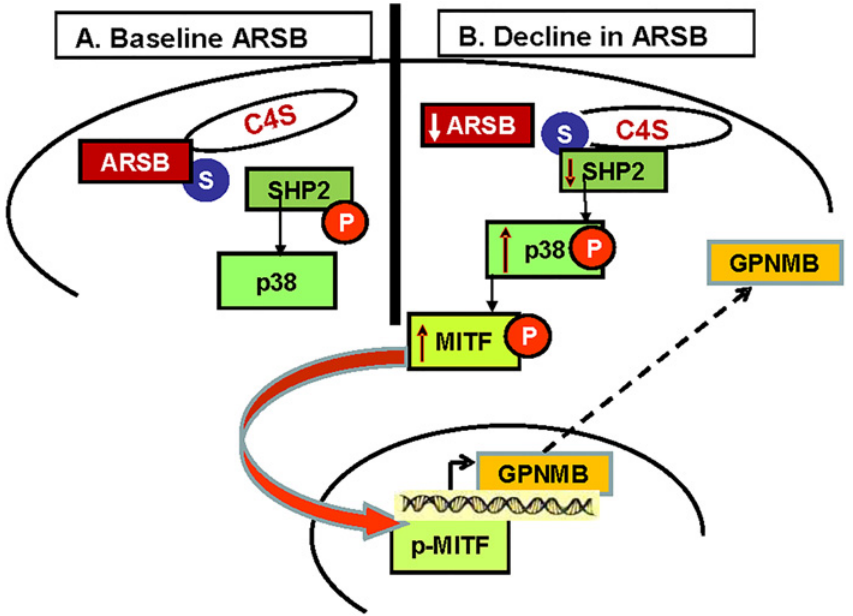
Fig 7. Schematic illustration of signaling pathway from # ARSB ! " chondroitin 4-sulfate ! " SHP2 bound ! # SHP2 activity ! " phospho-p38 ! " MITF ! " GPNMB. (A) When ARSB activity is normal, the 4-sulfate group at the non-reducing end of the C4S chain is removed from C4S and the binding of SHP2 to C4S is not increased. Hence, SHP2 can remove tyrosine phosphate from p38. (B) When ARSB is reduced and chondroitin 4-sulfation is increased, SHP2 binding to C4S is increased and SHP2 activity is reduced. There is inhibition of removal of tyrosine phosphate from p38, leading to increased phosphorylation of p38 and of MITF, leading to activation of the GPNMB promoter. [ARSB = arylsulfatase B; C4S = chondroitin 4-sulfate; GPNMB = glycoprotein (transmembrane) NMB; MITF = microphthalmia-associated transcription factor; P = phosphate; S =